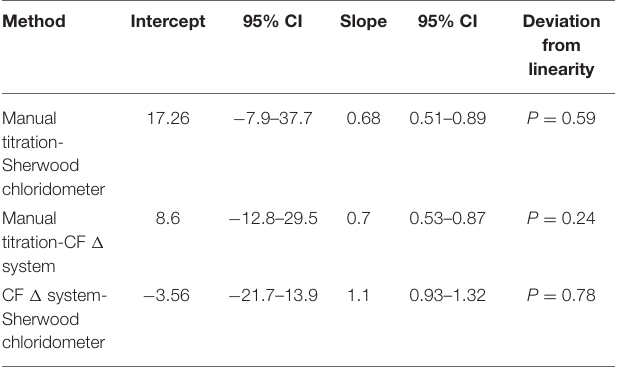
TABLE 3 | The Passing Bablok regression analysis of the results of manual titration, Sherwood chloridometer, and coulometric end point methods (CF 1 System) in CF patients ( n = 59).